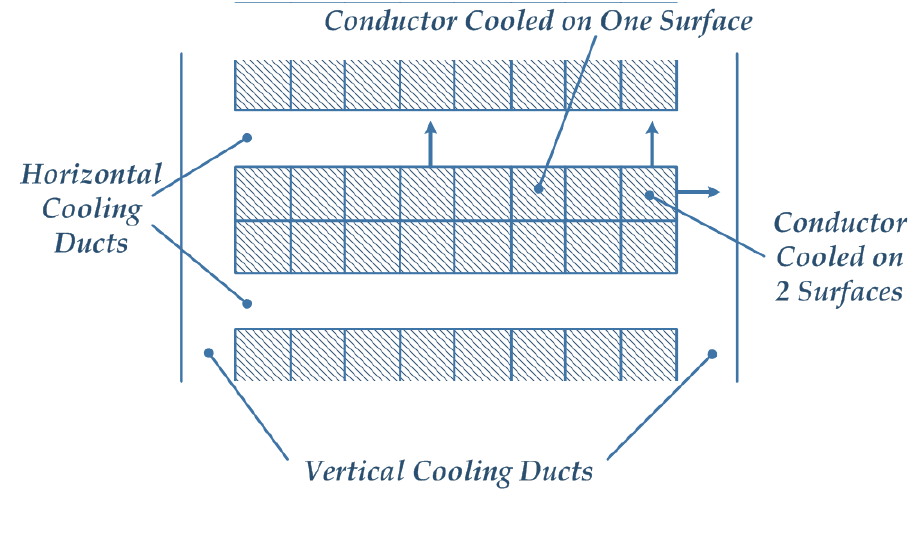
Figure 3. Winding hot